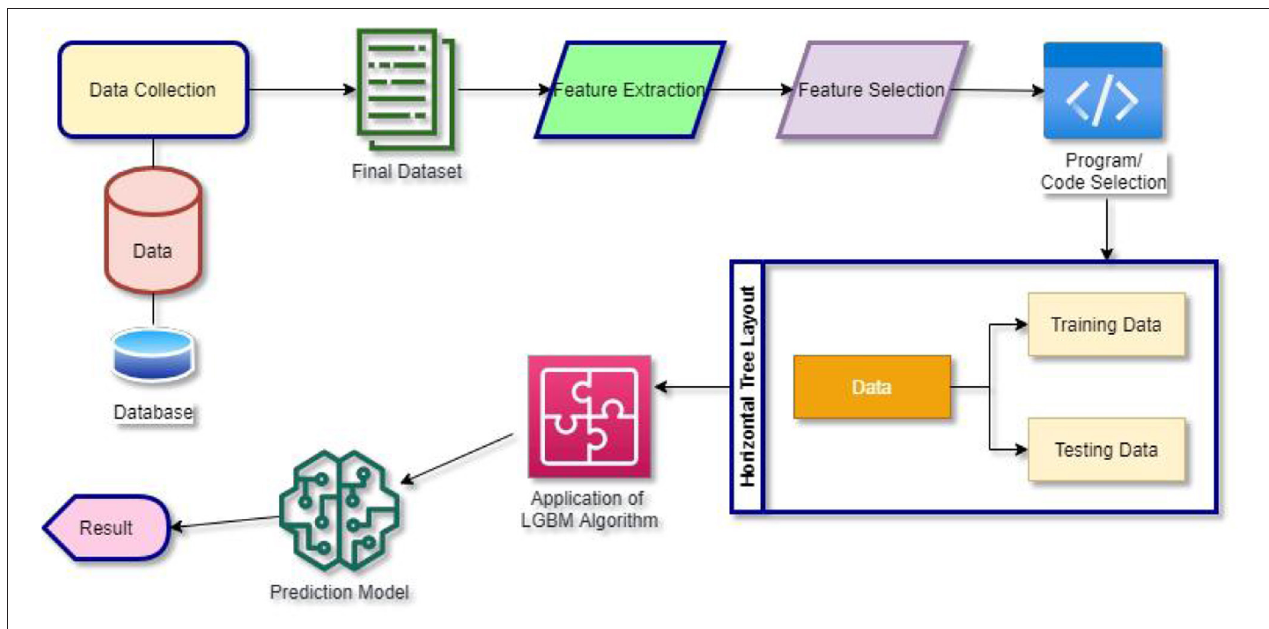
FIGURE 1 | Architectural